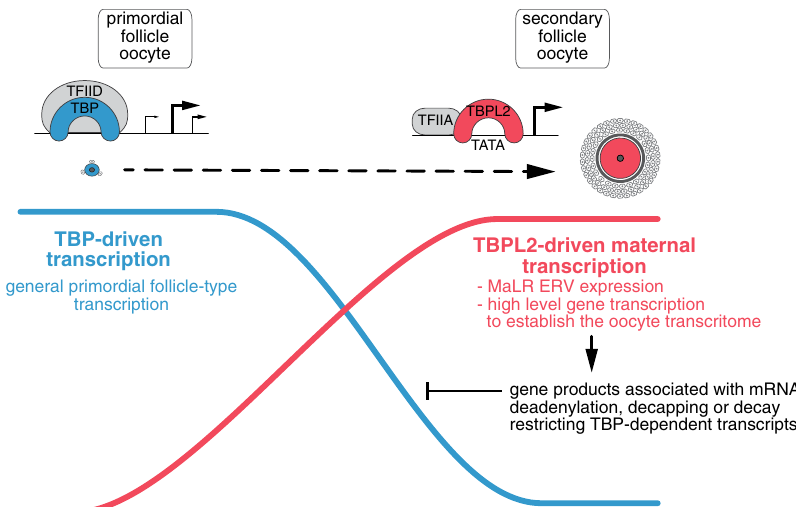
Fig. 7 Transcriptome overhaul controlled by TBPL2/TFIIA during oocyte growth. At the beginning of oocyte growth, the transcriptome in primordial and early primary follicles (blue cell) depends on TFIID/TBP (blue complex) transcription from broad promoters (blue line). As TBP protein disappears, Pol II transcription initiation is mediated (red line) only by the oocyte-speci fi c TFIIA/TBPL2 complex (red complex) from sharp promoters. At the growing oocyte stage (red cell) TFIIA/TBPL2 complex is responsible for initiating high levels of Pol II transcription, such as mammalian apparent LTR retrotransposons (MaLR) endogenous retroviral elements (ERV) expression and also the expression of genes of which the gene products survey/limit the stability and/or translatability of transcripts previously deposited by TFIID/TBP-dependent Pol II